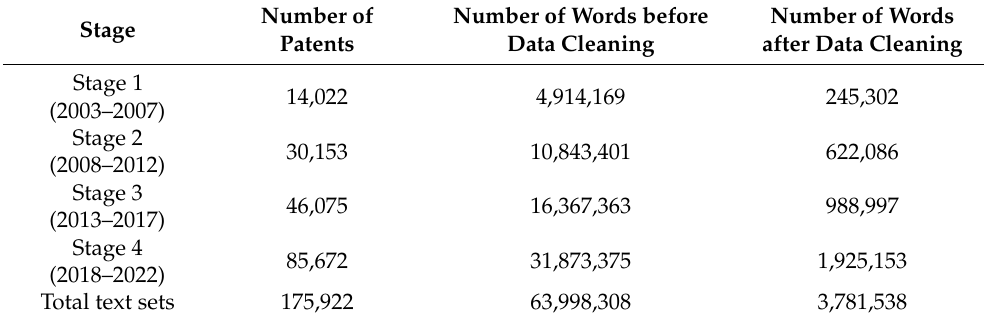
Table 1. Number of CCUS technology patents and vocabulary by stage, 2003–2022.